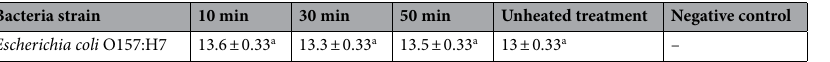
Table 2. The mean of diameter of inhibition zone (Millimeters) after heating the thanatin in 10, 30, and 50 min at 100 °C with standard error of the mean (SEM). Negative control: The culture media without thanatin. a No significant different between mean of diameter of inhibition zone.